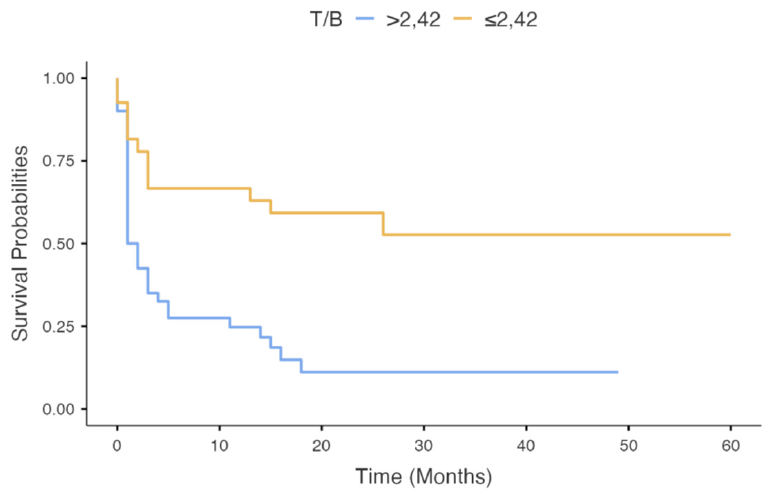
Figure 2. Kaplan–Meier estimates for overall survival by T/B ( p = 0.031).